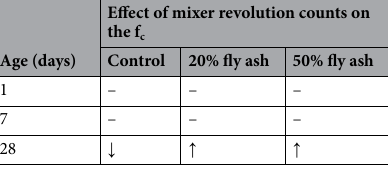
Table 4. Summary of the effect of mixer revolution count on the f c of mixtures at different ages ( ↑ = increase; ↓ = decrease; and – = similar).